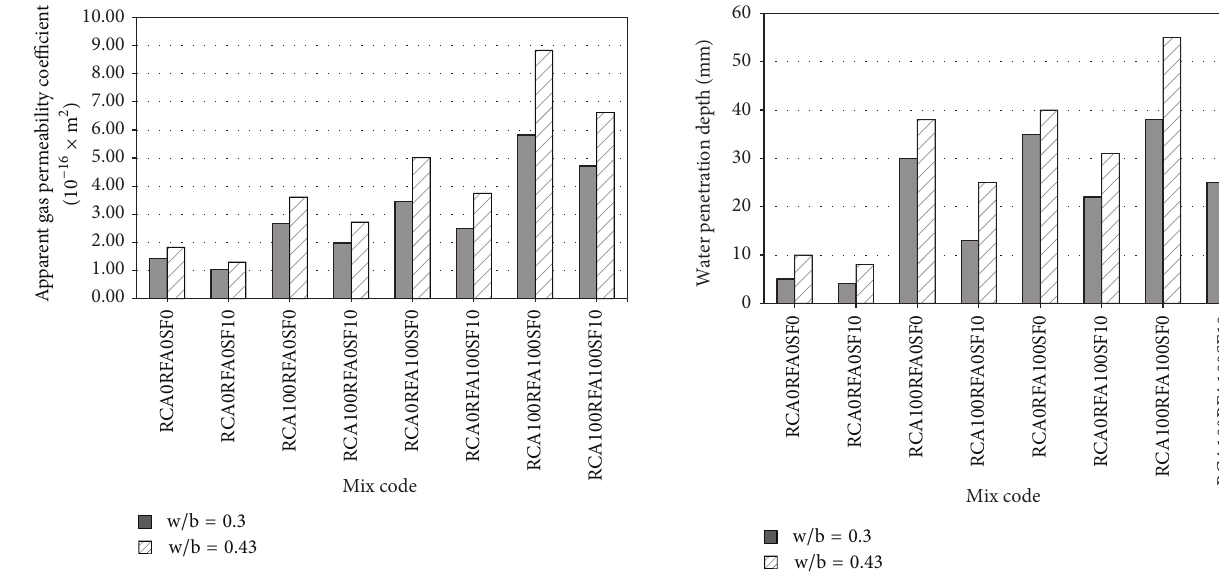
Figure 11: Water penetration depths of SCCs at 56